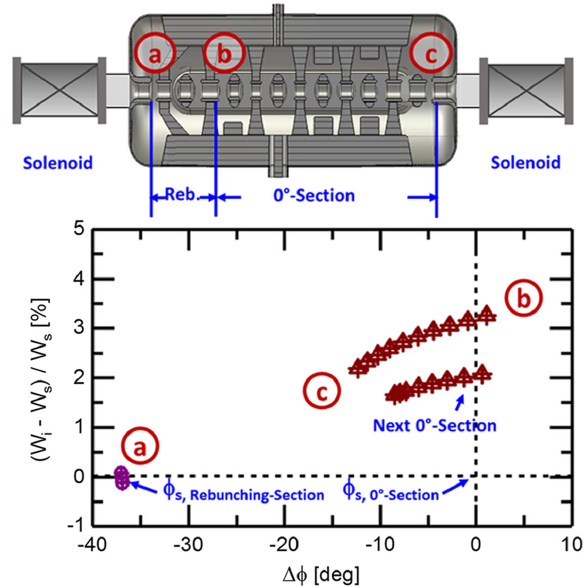
FIG. 4. A combination of KONUS and SC CH for accelerating very high intensity